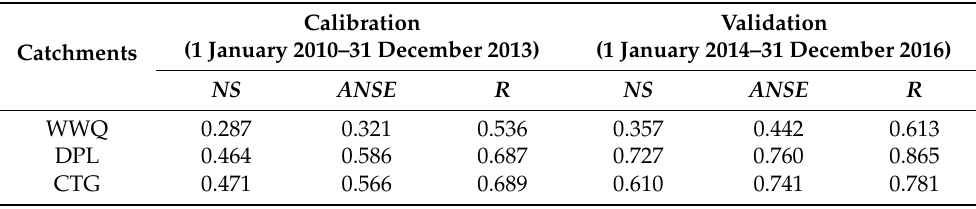
Table A1. Performance of the HBV model in the calibration and validation periods for the three basins.